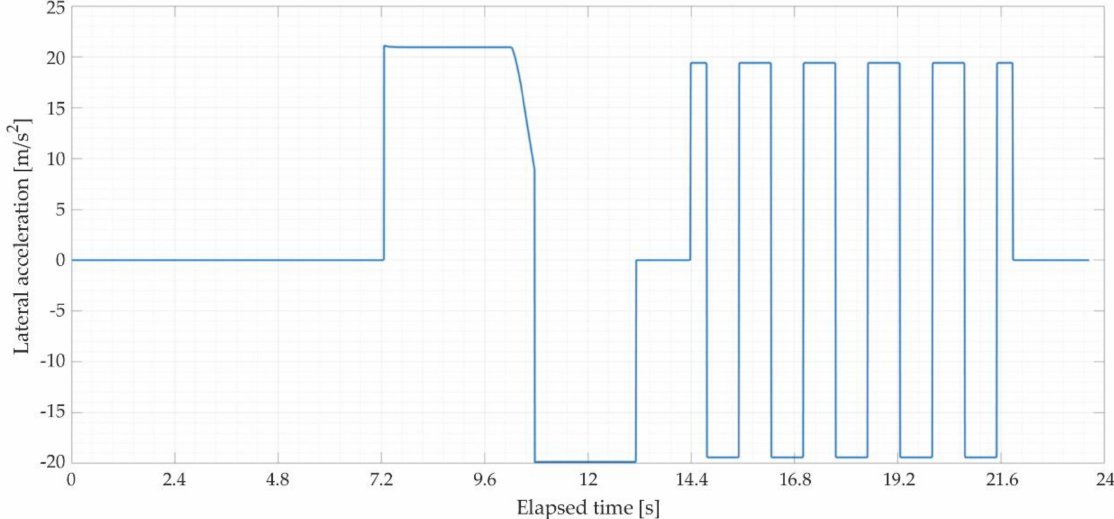
Figure 7. Lateral acceleration versus lap time.